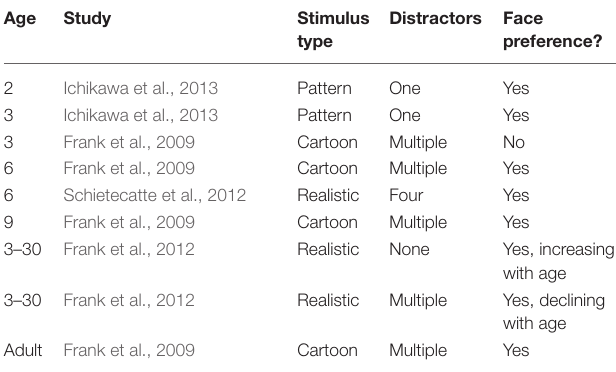
TABLE 1 | Overview of studies on face preference using static images. TABLE 2 | Overview of studies on face preference using dynamic